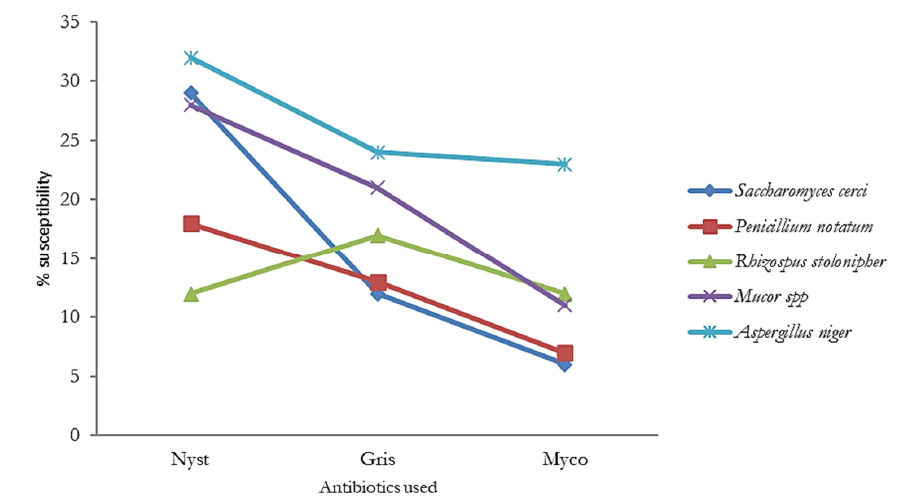
Figure 2. Antibiotic Susceptibility profile of fungi isolated from bread Nyst – Nystatin, Gris – Griseofulvin, Myco –